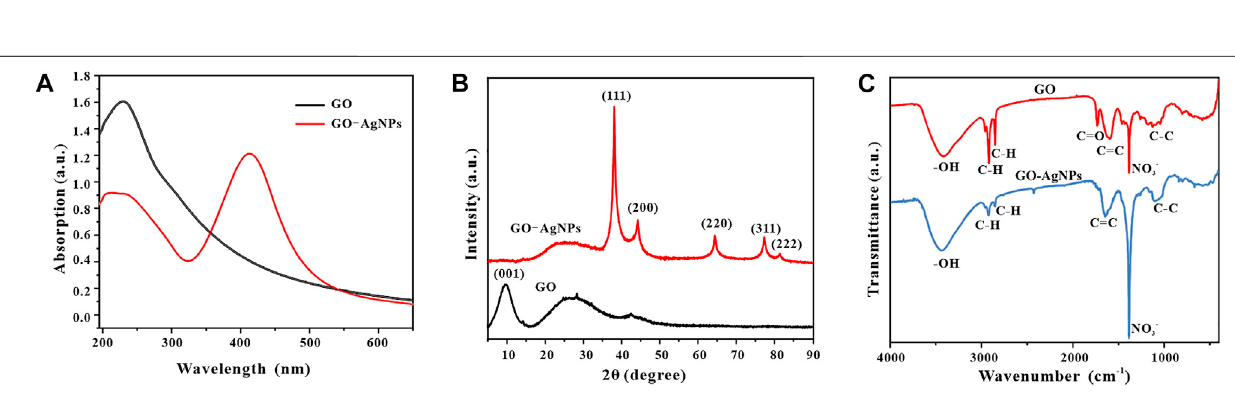
Frontiers in Chemistry |